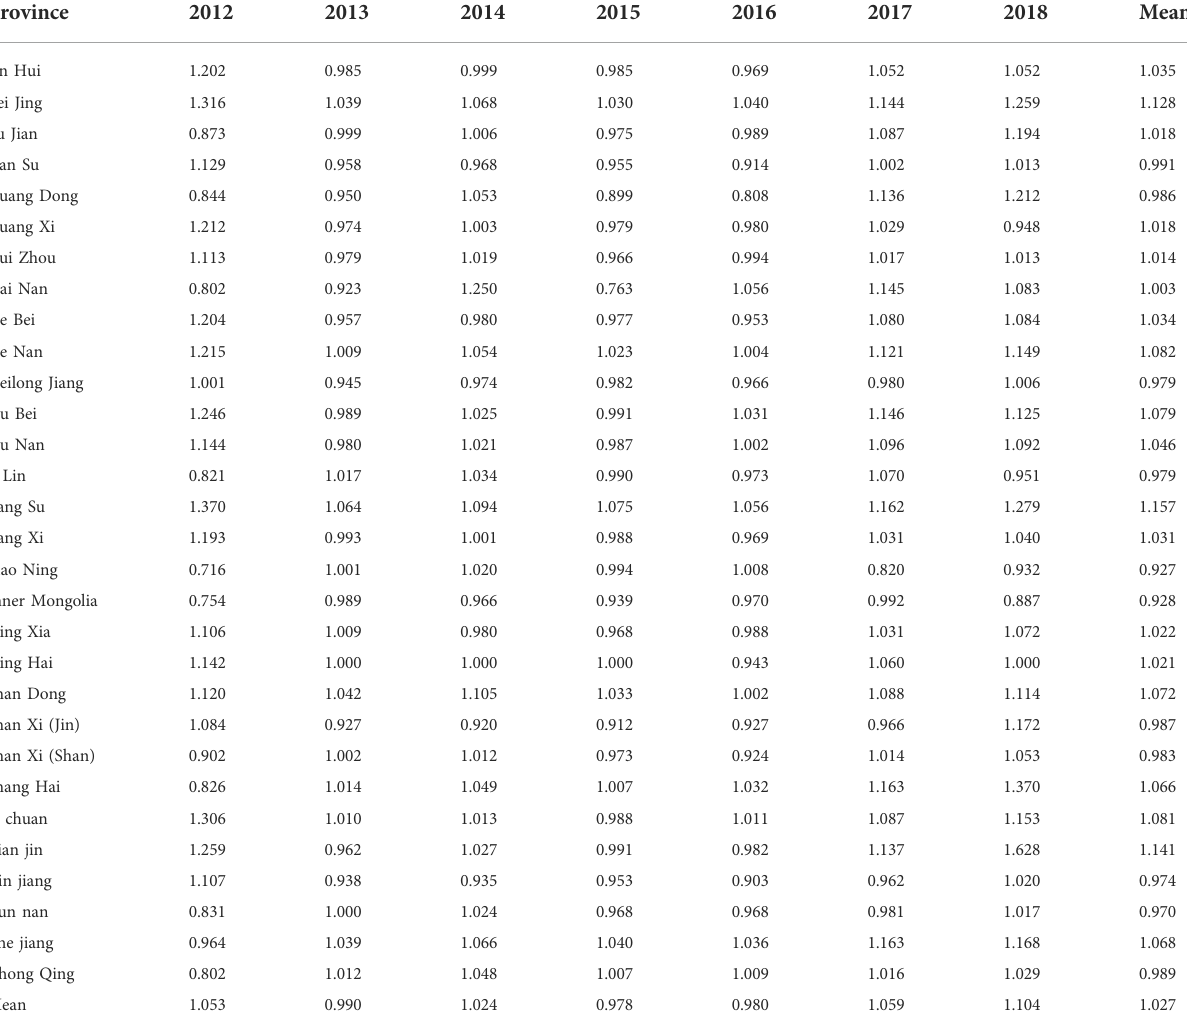
TABLE 5 China provincial green total factor productivity (GTFP) in 2012 –